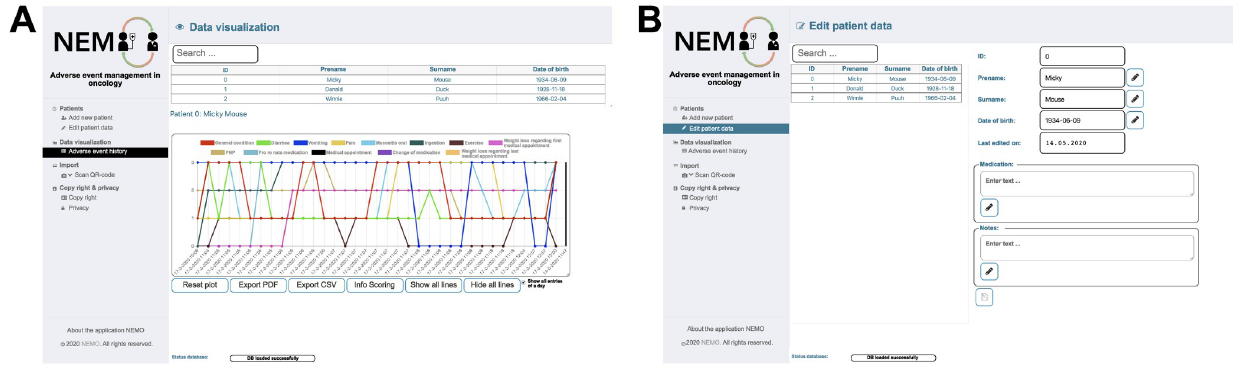
Fig 5. Visualization of transferred adverse events. The physician in charge can display patients’ transferred data of occurred adverse events as a line plot (a) or heat map (b). This allows a fast and easy analysis.